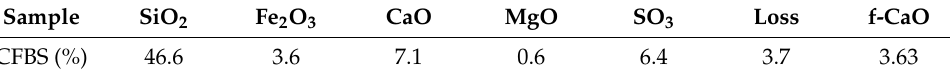
Figure 1. The XRD patterns of CFBS.